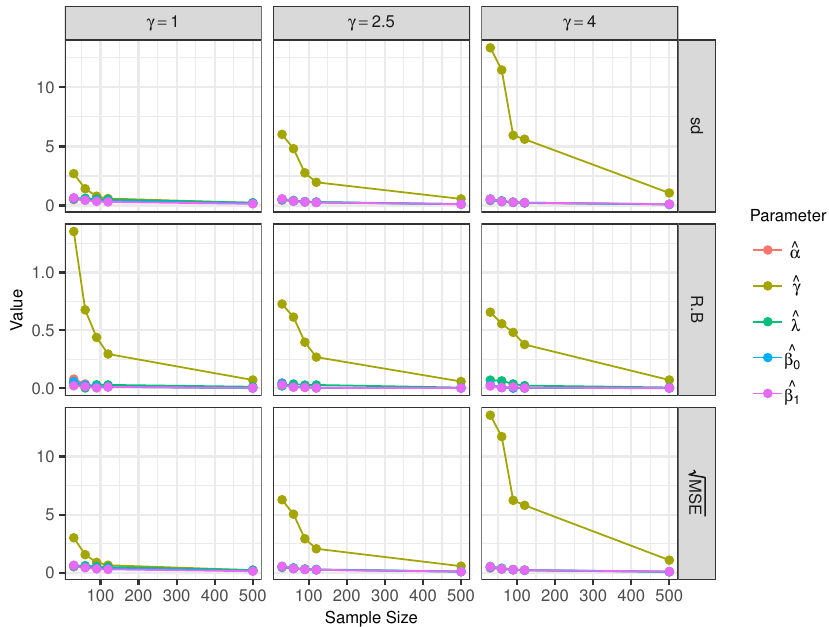
√ MSE for the estimators of the EGSHN ( 1.75,2.25,0.75, γ ,1 ) Figure 4. Empirical sd, relative bias, and model parameters with sample sizes of 30, 60, 90, 120 and